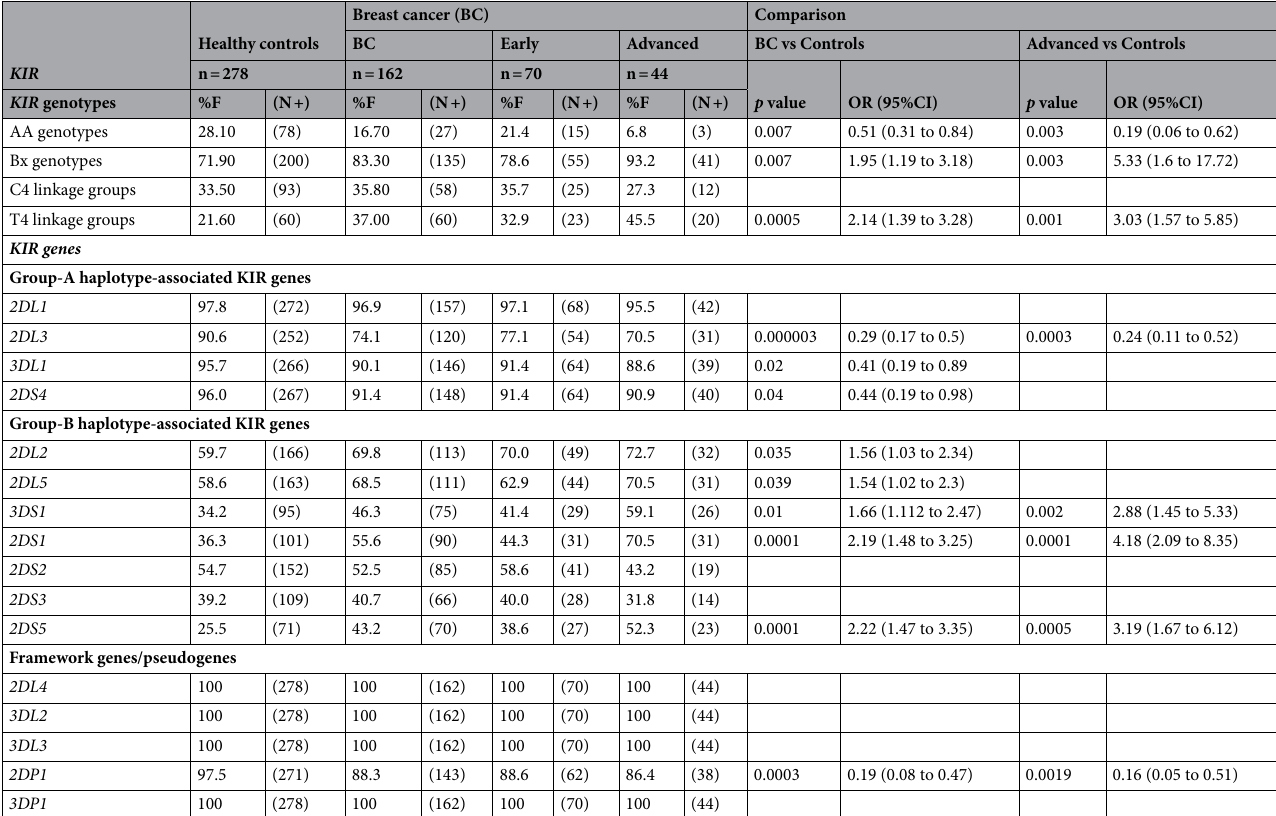
Table 1. Frequency of KIR genotypes, linked gene groups, and genes in breast cancer patients and controls. Carrier frequency (%F) of each genotype is expressed as a percentage and defined as the number of individual having the genotype (N +) divided by the number of studied (n) in the study